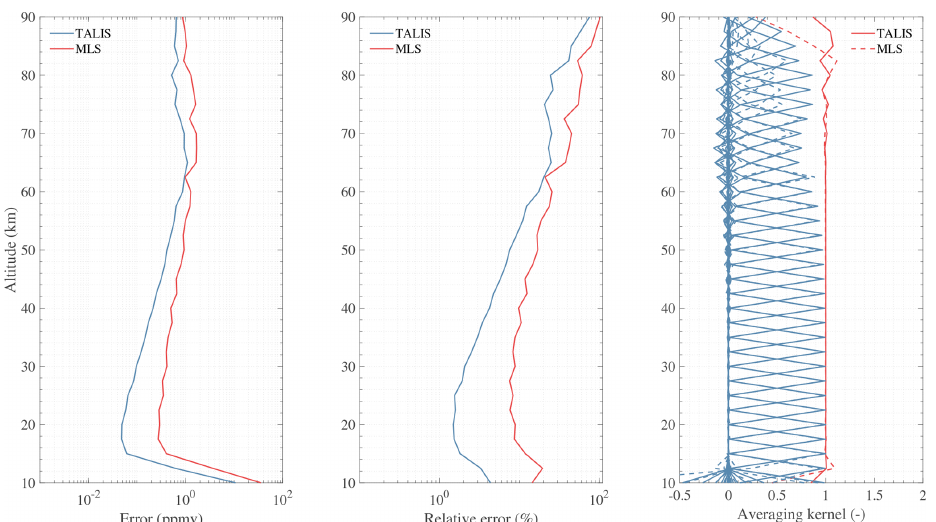
Figure 11. O 3 product comparison between the TALIS FFT spectrometer and MLS “Standard”’ spectrometer using the 235.71GHz line. All other factors are